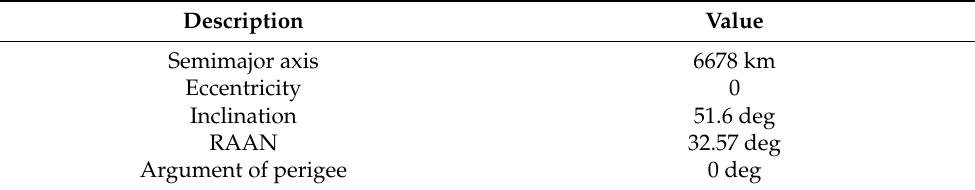
Table 1. Orbital parameters.